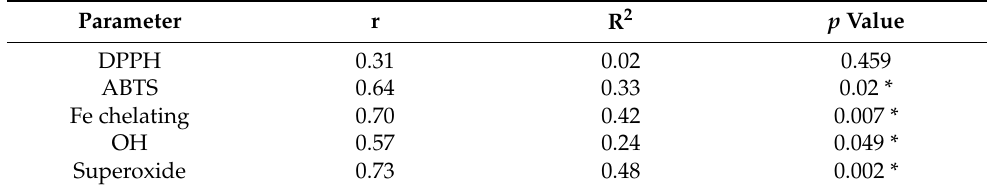
Table 6. Linear correlations between measured values and those predicted with the PARAFAC model antioxidant